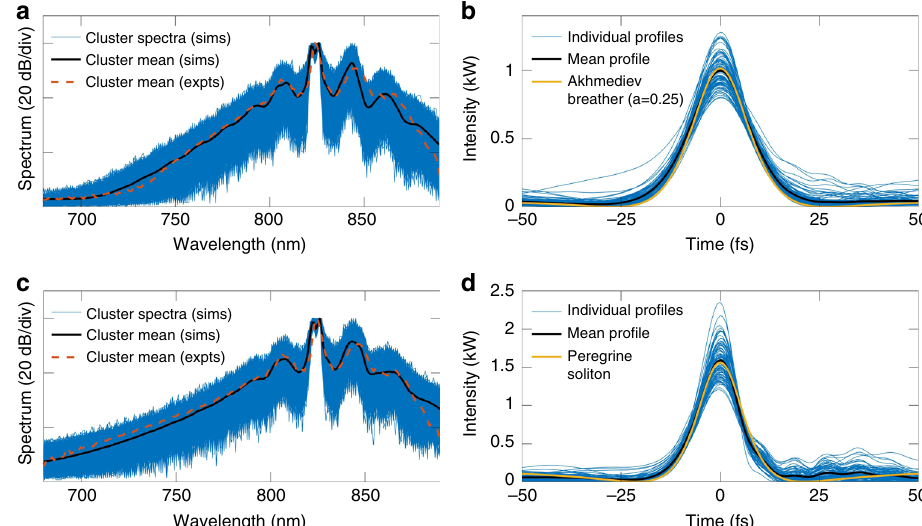
Fig. 4 Unsupervised learning analysis of 50,000 simulated MI spectra. a Superposed blue curves show the cluster of spectra whose mean is closest to the mean spectrum calculated from the full ensemble. The average of this cluster is the black line. The corresponding temporal data is shown in b where the superposed blue curves show the pro fi les of the highest intensity peaks in the time-domain fi eld associated with the spectra in a . The average temporal pro fi le is shown in black and compared with the analytic Akhmediev breather pro fi le (yellow) calculated at the maximum MI gain. c , d Shown are corresponding results for the cluster of spectra exhibiting the largest mean bandwidth. The yellow curve in the time-domain data plotted in d is the analytic Peregrine soliton. The red dashed lines in a and c show the average spectra calculated from clustered experimental data under the same conditions as